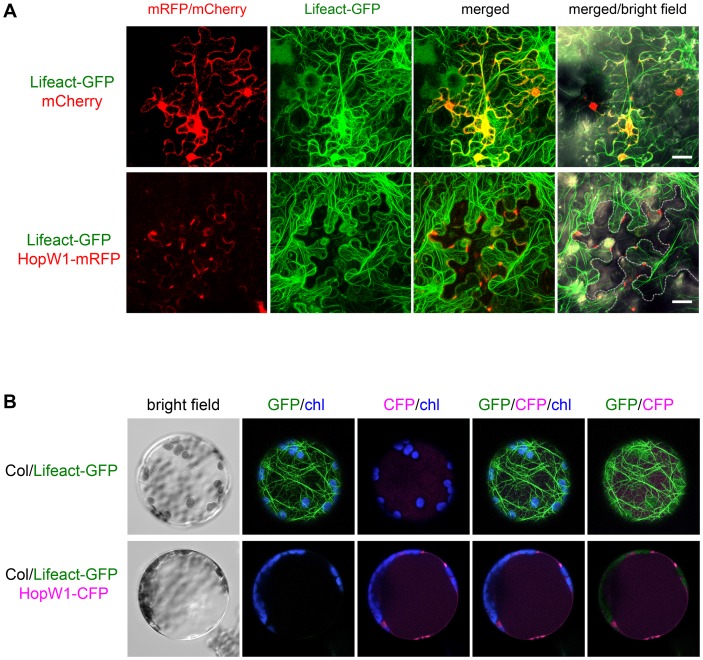
HopW1 disrupts the actin cytoskeleton when expressed in plant cells.Localization and effect of HopW1 on actin cytoskeleton was monitored in transiently transformed cells using laser scanning confocal microscopy. Representative micrographs shown are Z-series maximum intensity projections. (A) Expression of HopW1-RFP and Lifeact-GFP F-actin marker in Nicotiana benthamiana leaves 36–40 h after co-transformation with Agrobacteria. Micrographs show localization of cytoplasmic mCherry (control, upper panel) and HopW1-RFP (lower panel) together with Lifeact-GFP. GFP/RFP fluorescence is shown in green/red, respectively. Dotted line shows cells expressing HopW1-RFP. Bar = 30 µm. (B) Arabidopsis Col protoplasts from a transgenic line that expresses Lifeact-GFP [26] were transfected with HopW1-CFP (lower panel) or without DNA (control, upper panel). Micrographs show Lifeact-GFP and HopW1-CFP 15 h after transfection. GFP/CFP fluorescence is shown in green/magenta, respectively, and chloroplast (chl) autofluorescence in blue. These experiments were repeated twice with similar results. The actin cytoskeleton was not detectable in all cells in which HopW1-RFP/CFP was observed (at least 30 N. benthamiana cells and 40 Lifeact-GFP Arabidopsis protoplasts, respectively, with HopW1 signal were observed).